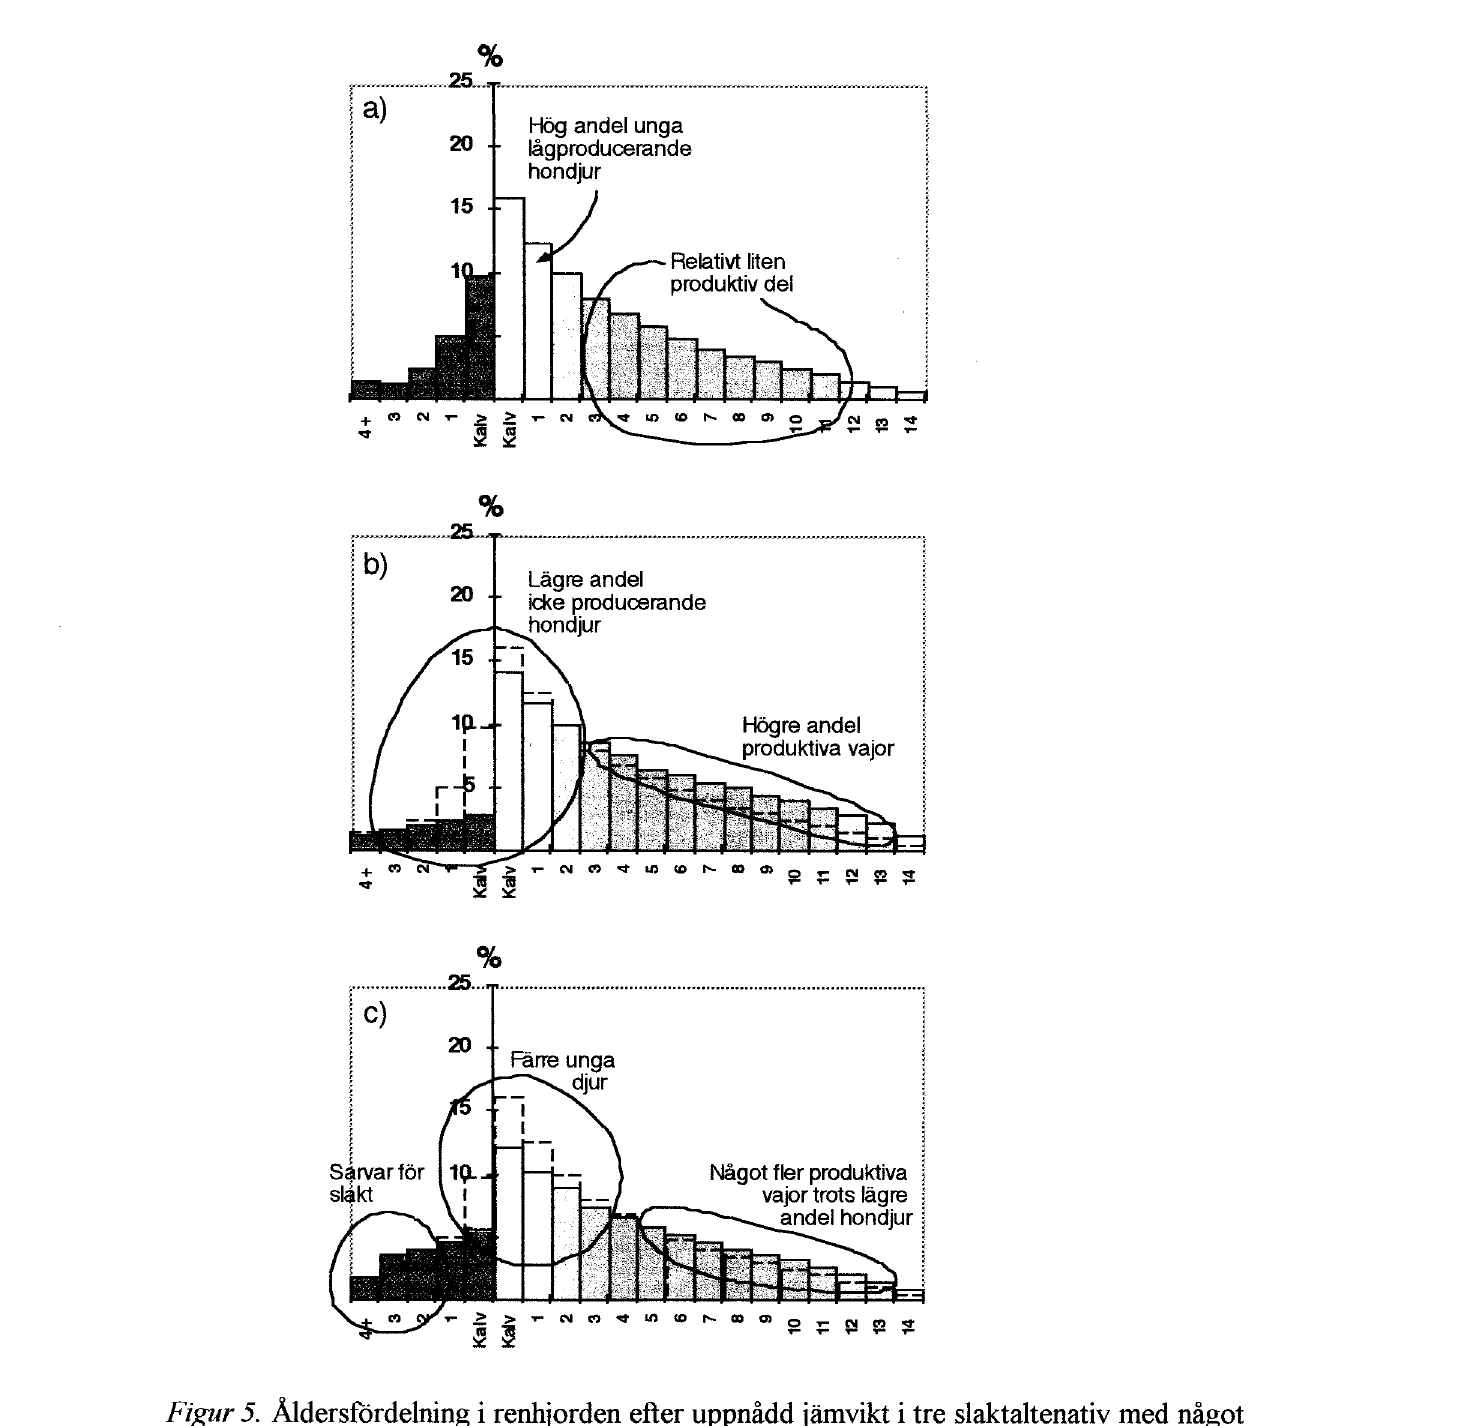
Figur 3 (och 4) visade exempel på beråknad produktionen vid olika konditionsnivå for ett proportionellt slaktalternativ med 80% hondjur och 20% handjur efter att ålderstrukturen stabiliserat sig. I figur 6 jåmfbrs detta med motsvarande exempel for ett kalvslaktalternativ med 90% hon- och 10% handjur, och två kombinerade sarv-/kalvslaktalternativ med